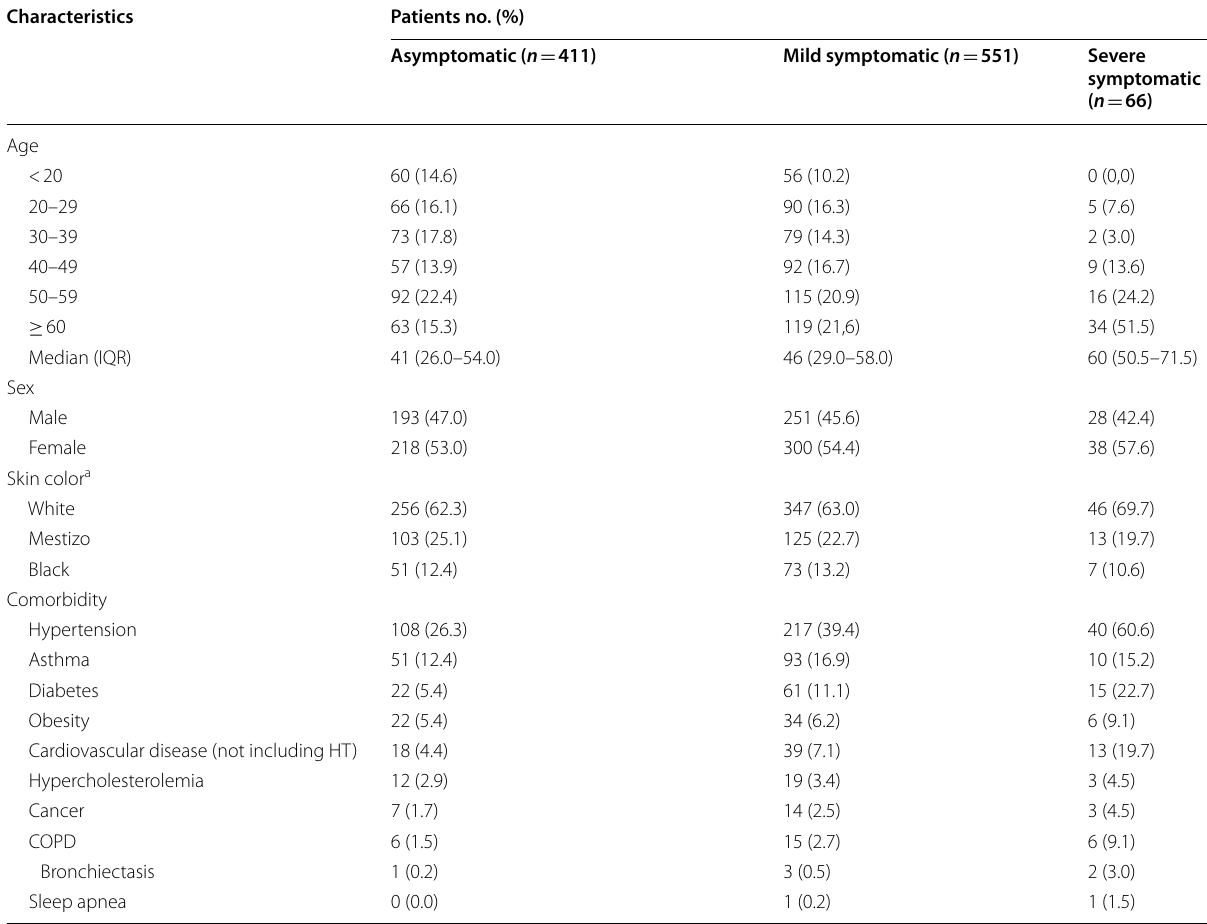
Table 1 Baseline characteristics of groups of patients with SARS‑CoV‑2 infection